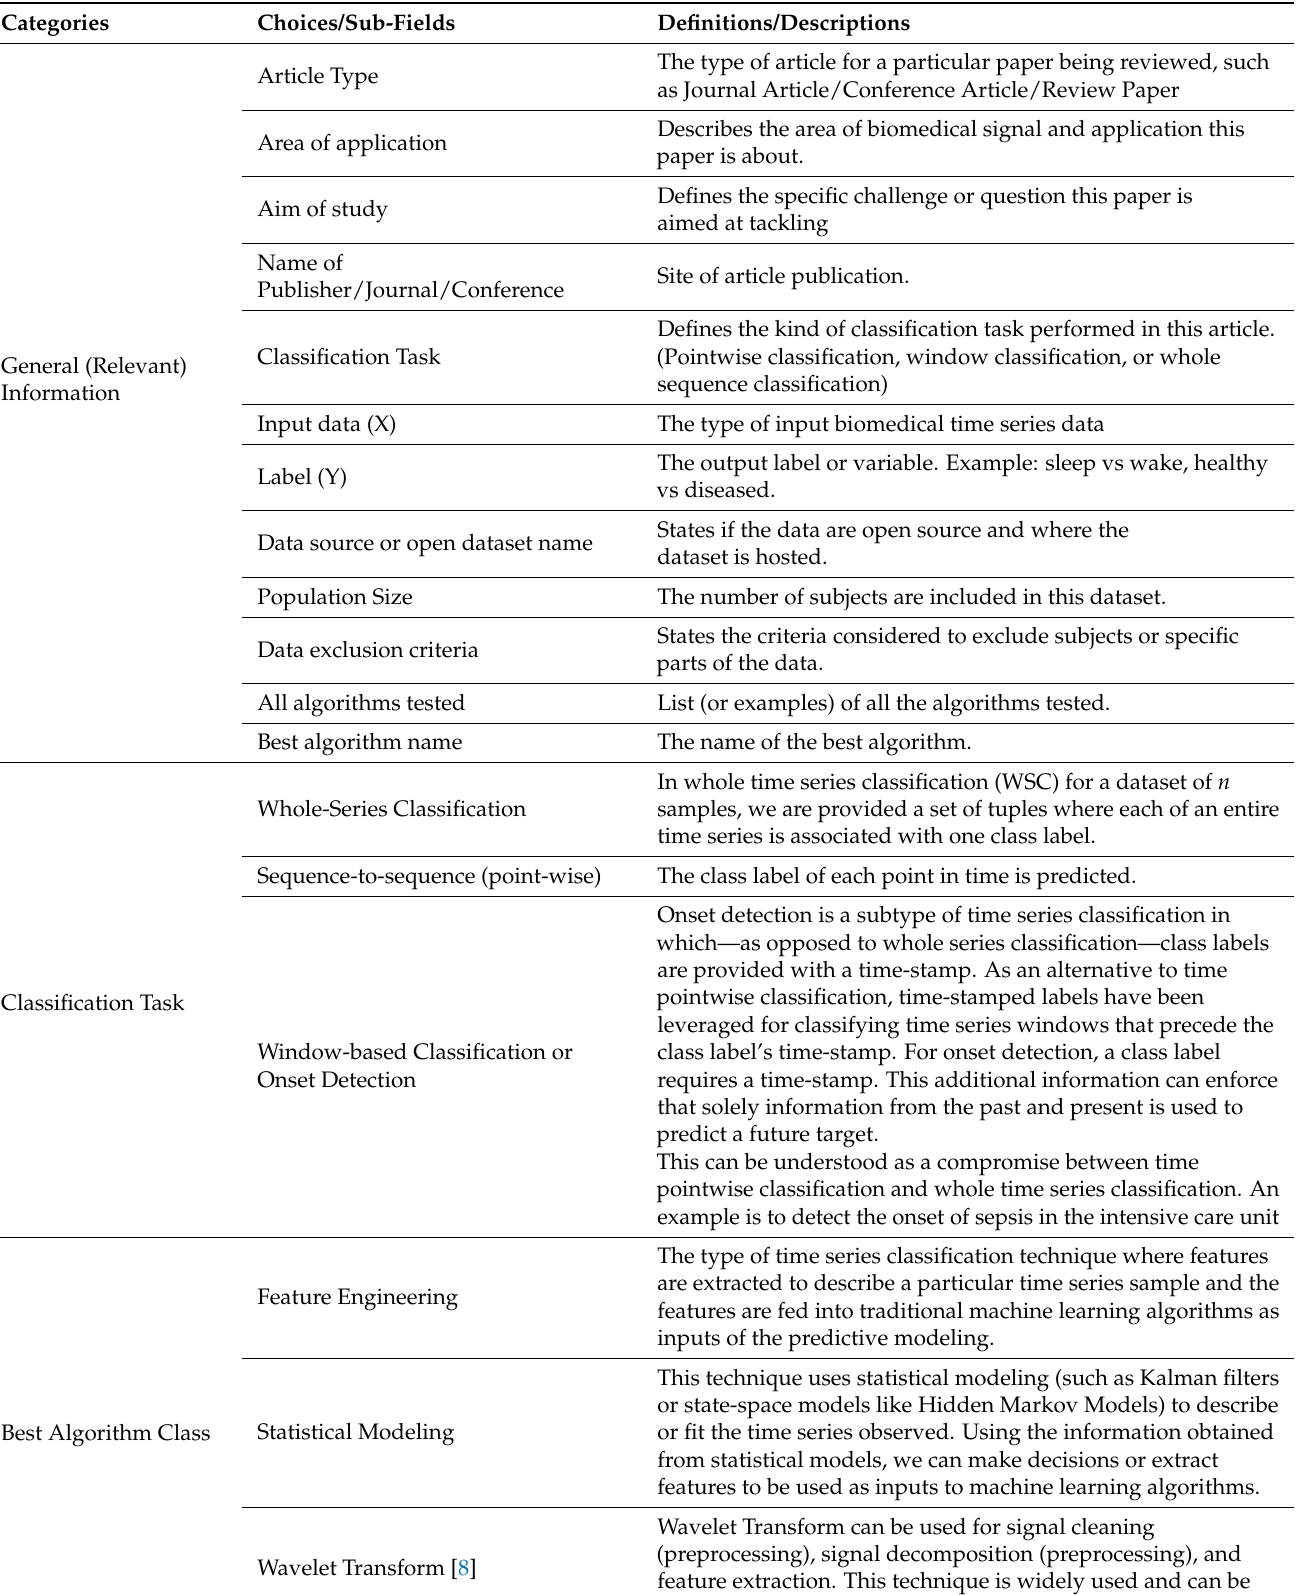
Table 1. Data fields extracted from identified academic